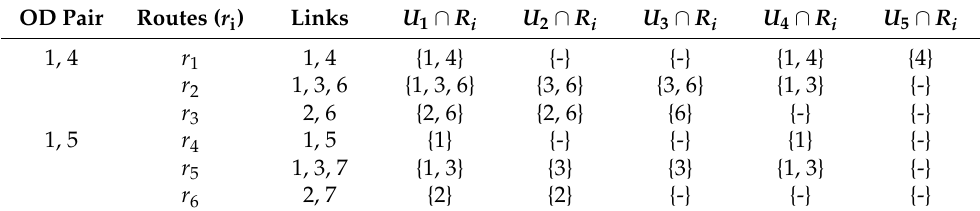
Table 3. Illustration of the process to replace scanning sensor.